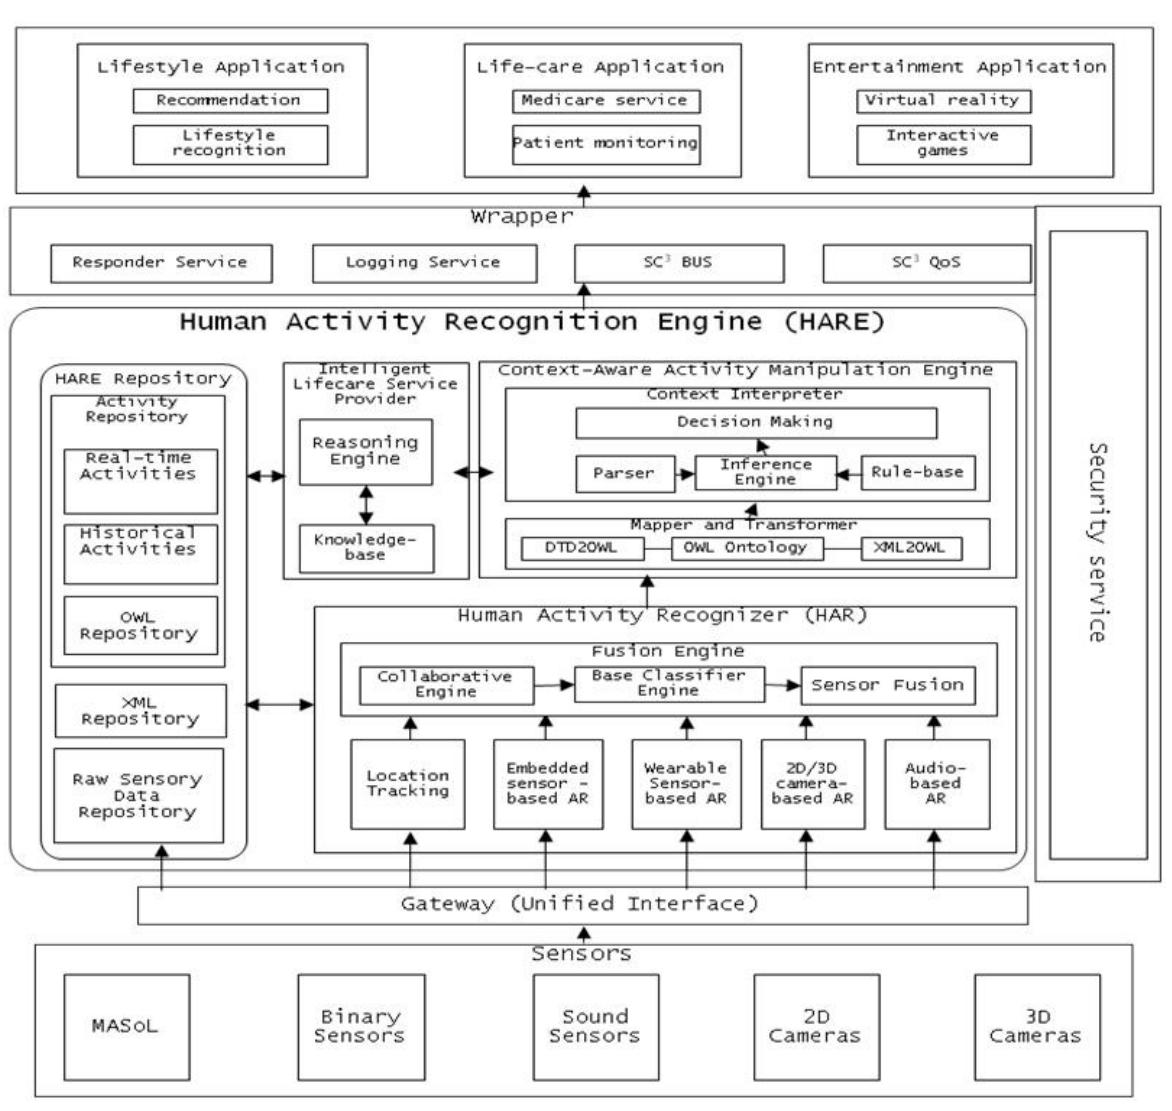
Figure 1. Architecture of Human Activity Recognition Engine